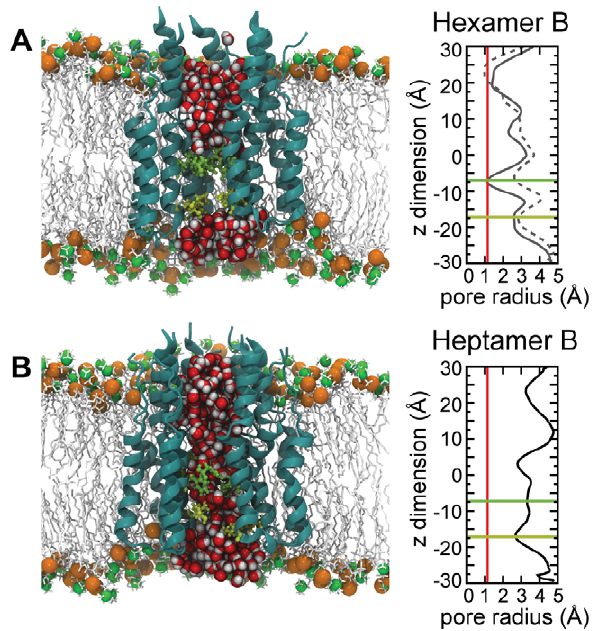
Figure 3. Molecular assemblies and pore-radius profiles of p7 Hexamer B (A) and Heptamer B (B) pores in a POPC bilayer. Left panels: side views of Hexamer B and Heptamer B (ribbon representa- tion) with water molecules inside the central pore represented as van der Waals spheres (red and grey). The side chains of F25 (in green) and I32 (in yellow) are represented as sticks. The model POPC bilayer is described by means of a stick representation (light grey), with phosphorus and nitrogen atoms displayed as glossy orange and green van der Waals spheres, respectively. Right panels: radial profiles depicting the width of the pore along the longitudinal axis of the complex were calculated using the program H OLE [73]. The red line is positioned at 1.4 A˚, the approximate radius of a water molecule. The green and yellow lines mark the approximate positions of F25 and I32, respectively. In the Hexamer B plot (A), the solid line represents the radial profile before the opening of the pore and highlights a constriction at the level of F25. The dotted line denotes the radial profile after the pore has opened (the protrusion near z=25 A˚ is the result of association between the N-terminal tails of the six subunits in the solvent below the membrane, and does not represent a blockage of the pore).